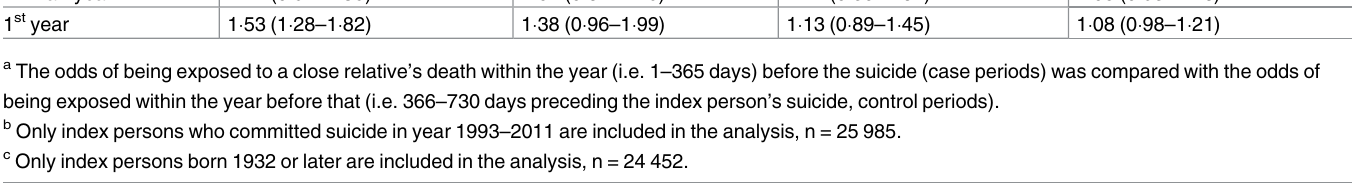
a The odds of being exposed to a close relative’s death within the year (i.e. 1–365 days) before the suicide (case periods) was compared with the odds of being exposed within the year before that (i.e. 366–730 days preceding the index person’s suicide, control periods). b Only index persons who committed suicide in year 1993–2011 are included in the analysis, n = 25 985. c Only index persons born 1932 or later are included in the analysis, n = 24